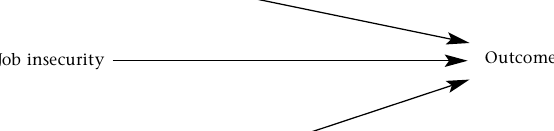
Figure 3: The moderation model